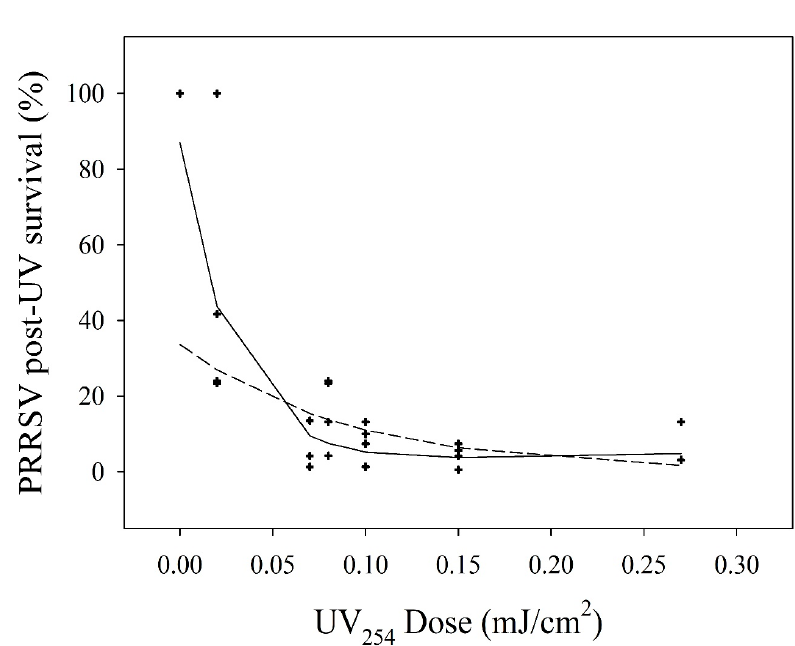
Figure 2. UV ‐ C (254 nm) treatment inactivation of aerosolized PRRSV. PRRSV post ‐ UV survival (%) = N t /N 0 . A log10 normalized PRRSV post ‐ UV survival is shown in Figure A1. One ‐ stage and two ‐ stage inactivation models are marked with dashed and solid lines, respectively.